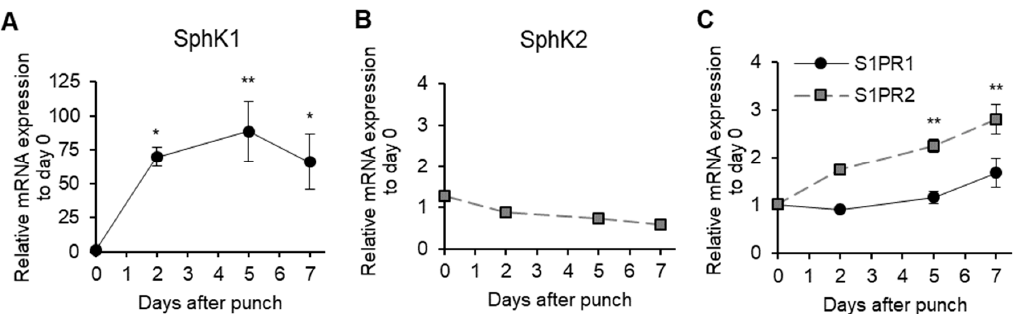
Figure 1. Longitudinal sphingosine-1-phosphate (S1P) production during mouse wound healing. Splinted excisional wounds ( n = 4–6) were generated in C57BL / 6J mice, and the mRNA expression of ( A ) sphingosine kinase-1 (SphK1), ( B ) sphingosine kinase -2 (SphK2), and ( C ) sphingosine-1-phosphate